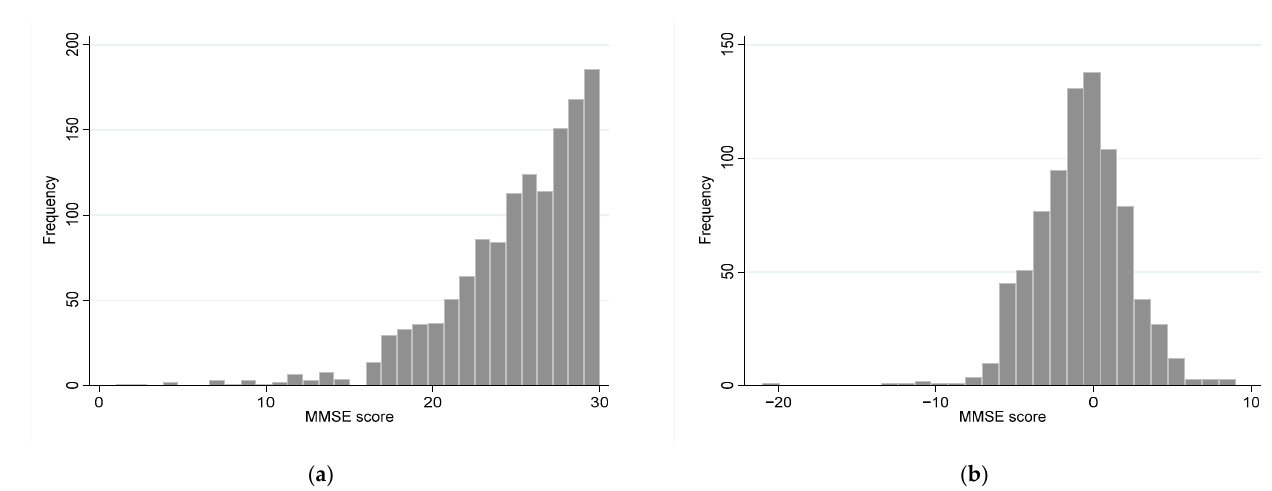
Figure 2. Histogram of MMSE score. ( a ) Distribution of the baseline MMSE score ( n = 1327); ( b ) Three-year changes in MMSE score ( n = 825). MMSE, Mini-Mental Status Examination.